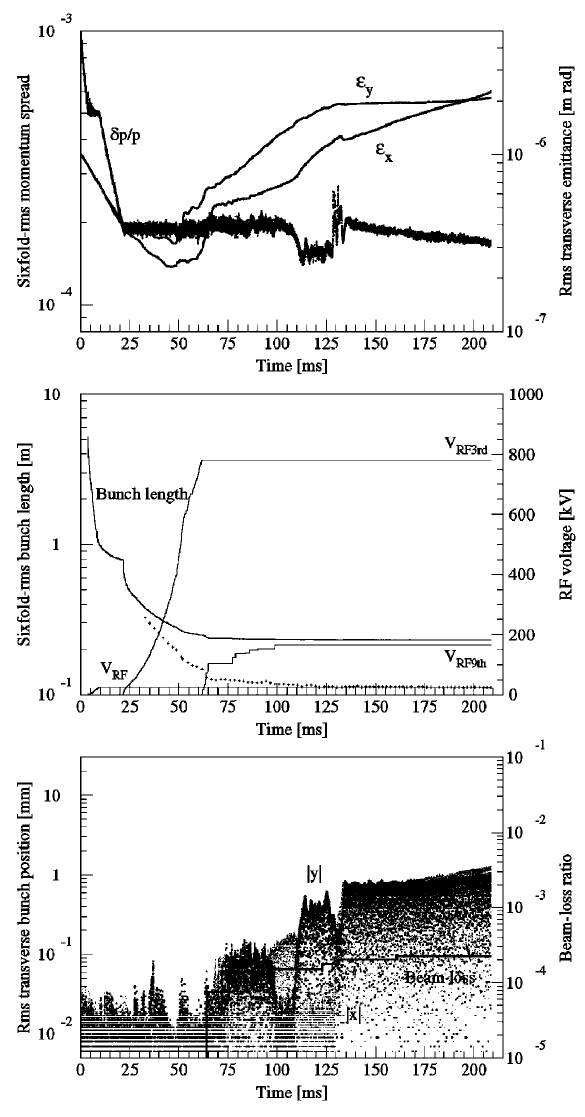
FIG. 11. Time evolution of the beam under the resonance control with the 9th-harmonic rf voltage applied additionally. In the middle panel the dotted curve indicates the sixfold-rms bunch length without counting the ions at z (cid:2) (cid:15) 1 m